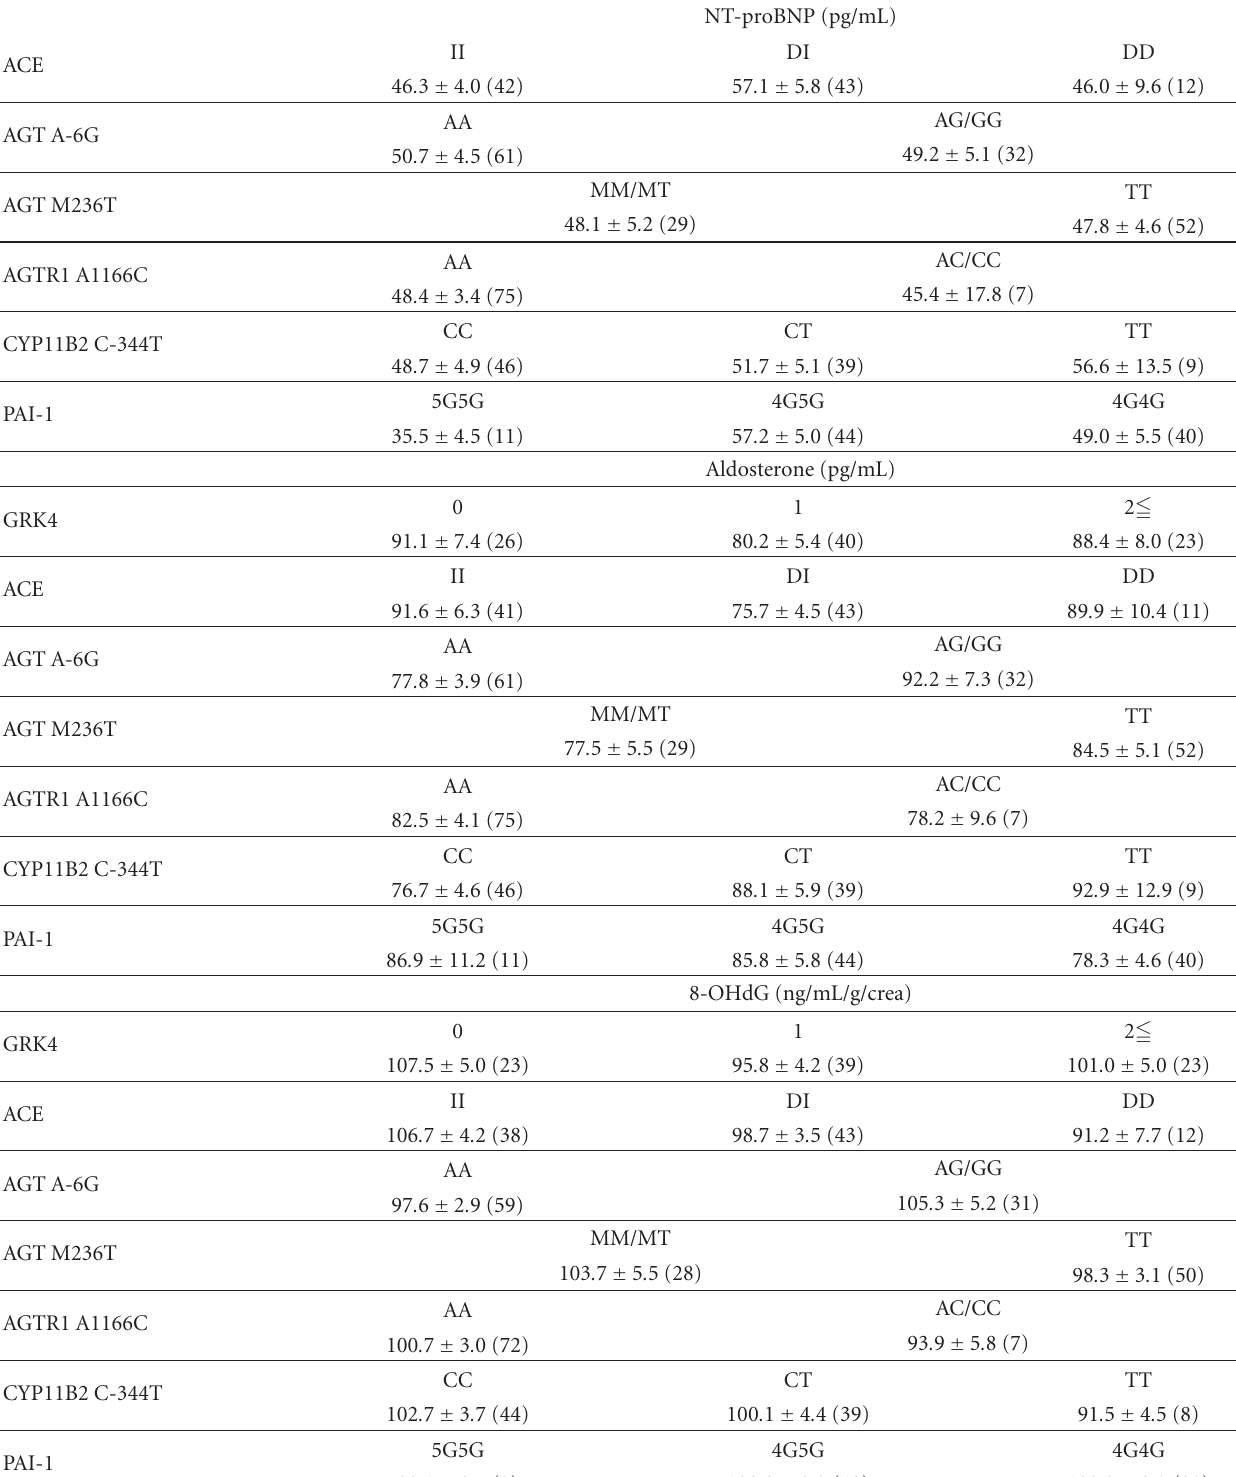
Table 2: Hypertension-related gene polymorphisms and serum NT-proBNP, plasma aldosterone, and urinary 8-OHdG